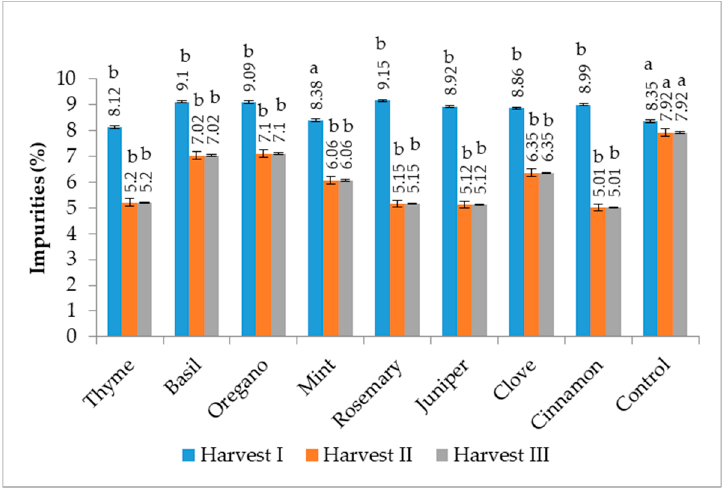
Figure 2. Impurities content (%) before (Harvest I), after (Harvest II) the use of EOs in the supple- mentary feed of bee families, respectively after the first harvest (rapeseed) (Harvest III). Different letters between control and samples indicate significant differences ( p < 0.05) among these values according to the t -test.